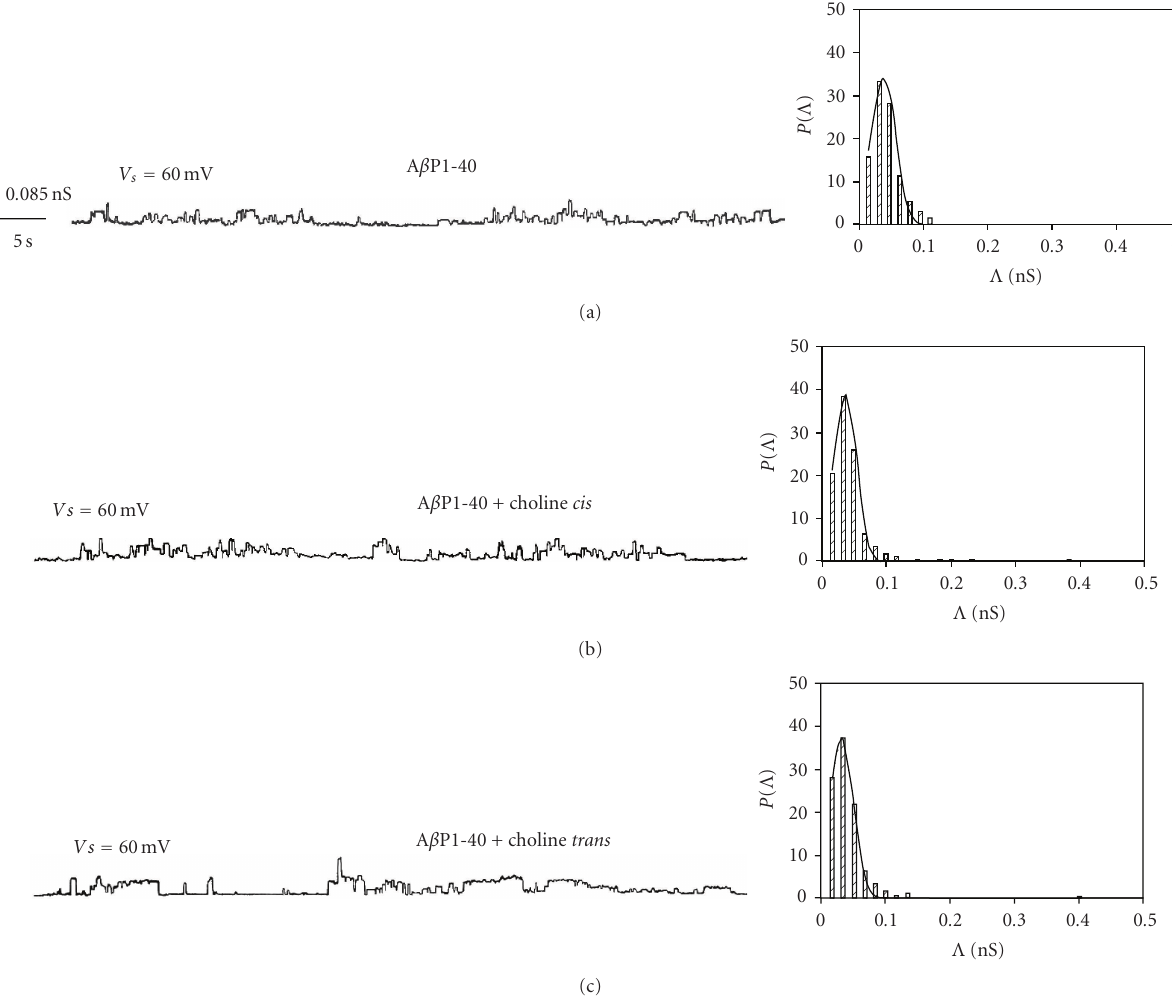
Figure 5: A β P1-40 channel activity in POPC:Ch PLM. Representative A β P1-40 channel in the absence (a) or in the presence of choline (5 × 10 − 11 M) on the cis (b) or on the trans (c) side of the medium facing a POPC:Ch (65:35, w/w) PLM at an applied voltage of 60 mV. Amplitude histograms of channel conductance for each trace are shown next to their respective traces.